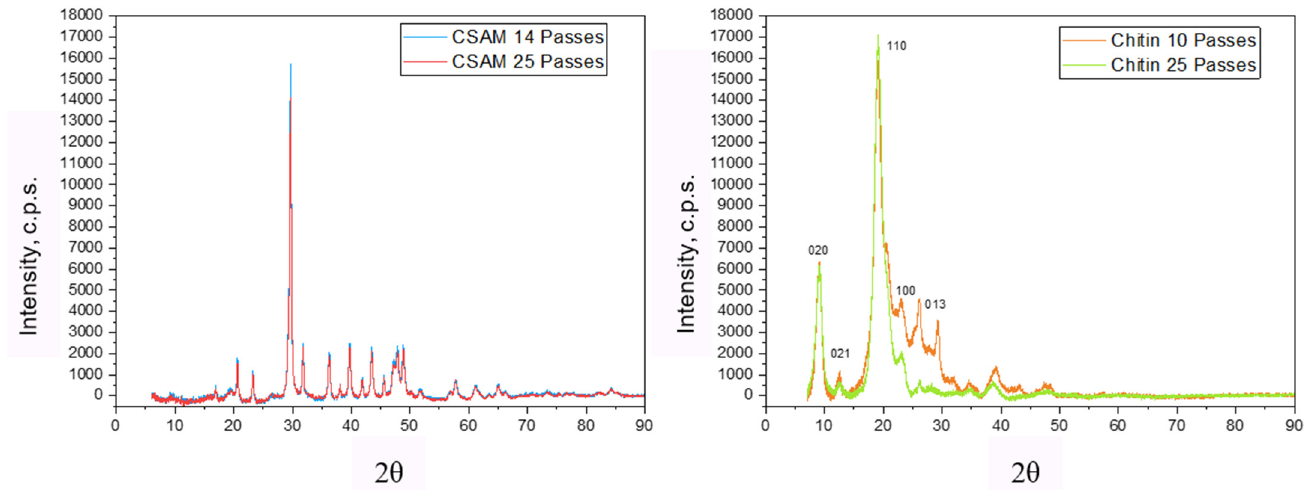
Figure 2. X-Ray diffraction patterns for crustacean shell (CSAM) and chitin after Masuko grinding over 14 and 25 grinding passes.